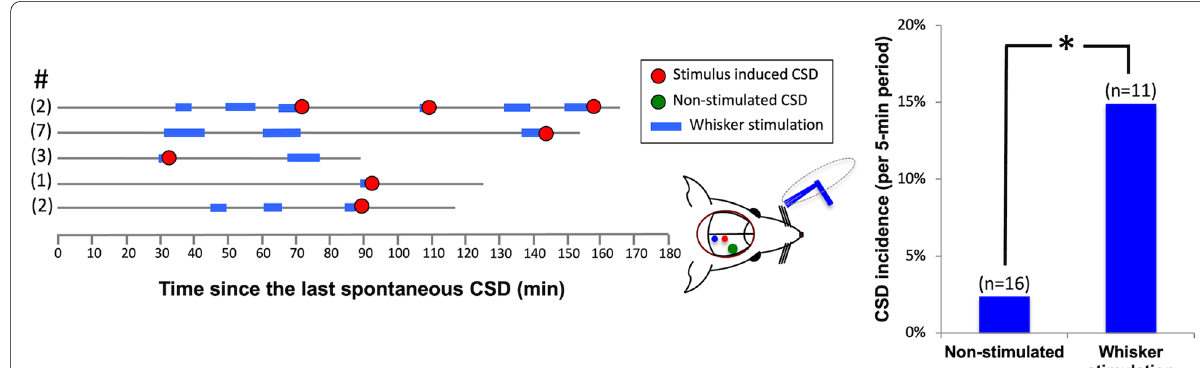
fig. 3 Priming the barrel cortex with ouabain increased the incidence of whisker stimulation‑induced CSDs. Each horizontal line represents continuous recording from one mouse primed with 0.1 mM ouabain and then subjected to whisker stimulation at 8–12 Hz for 10 min except a few that lasted a bit shorter or longer due to interventions needed (e.g. for clearing the airway) or timing errors in stimulator. Stimulation started after at least a 30‑min silent period without any CSD. The number of ouabain‑induced CSDs prior to starting stimulation is given before each line in parentheses. Stimulation (labeled blue) was stopped when a CSD was triggered (red circles). Green circles depict the occasional CSDs unrelated to stimulation. Bar graph shows that the CSD incidence was significantly higher (* p 0.026, Chi‑square test) during whisker stimulation compared = to the non‑stimulated periods. Only positive experiments are displayed on the left to simplify viewing of the flow charts by omitting the negative experiments ( n 6), but statistical analysis on the right included all animals regardless of the stimulation effectiveness (11 mice) and compared = them to 16 non‑stimulated mice treated with 0.1 mM ouabain. Because the CSD incidence was very low in controls, it was not suitable for illustration (i.e. 16 lines mostly with no incidences)